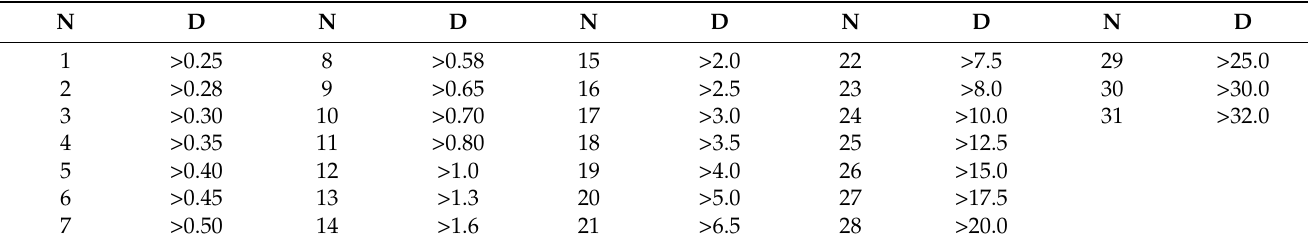
Table 1. The 31 particle channels of EDM180, N represents the channel order and D represents the channel diameter in the unit of